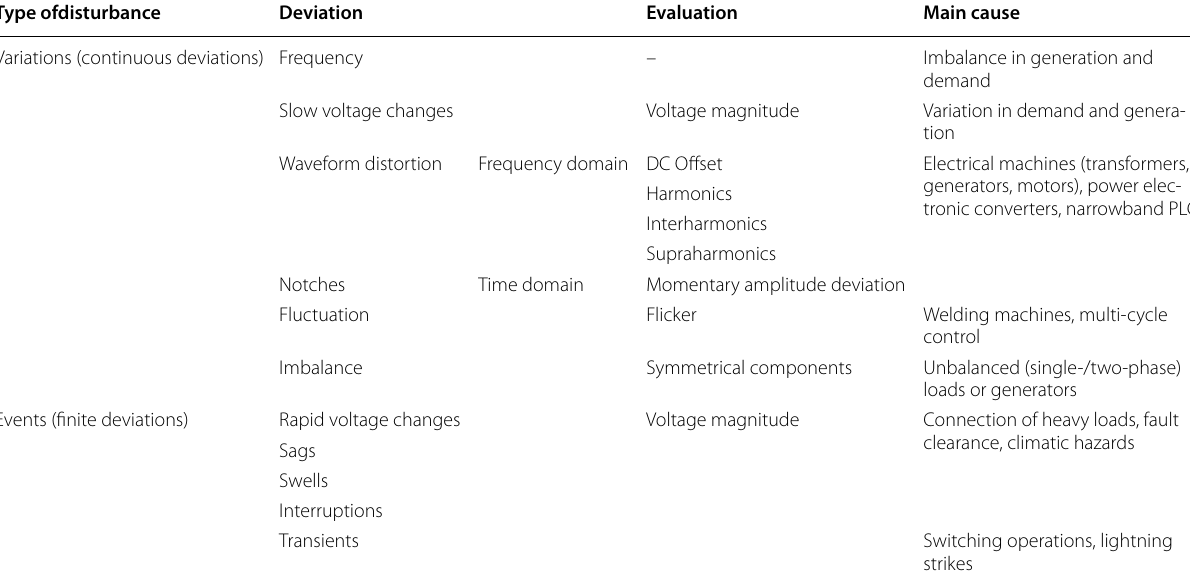
Table 1 Classification of typical PQDs Type